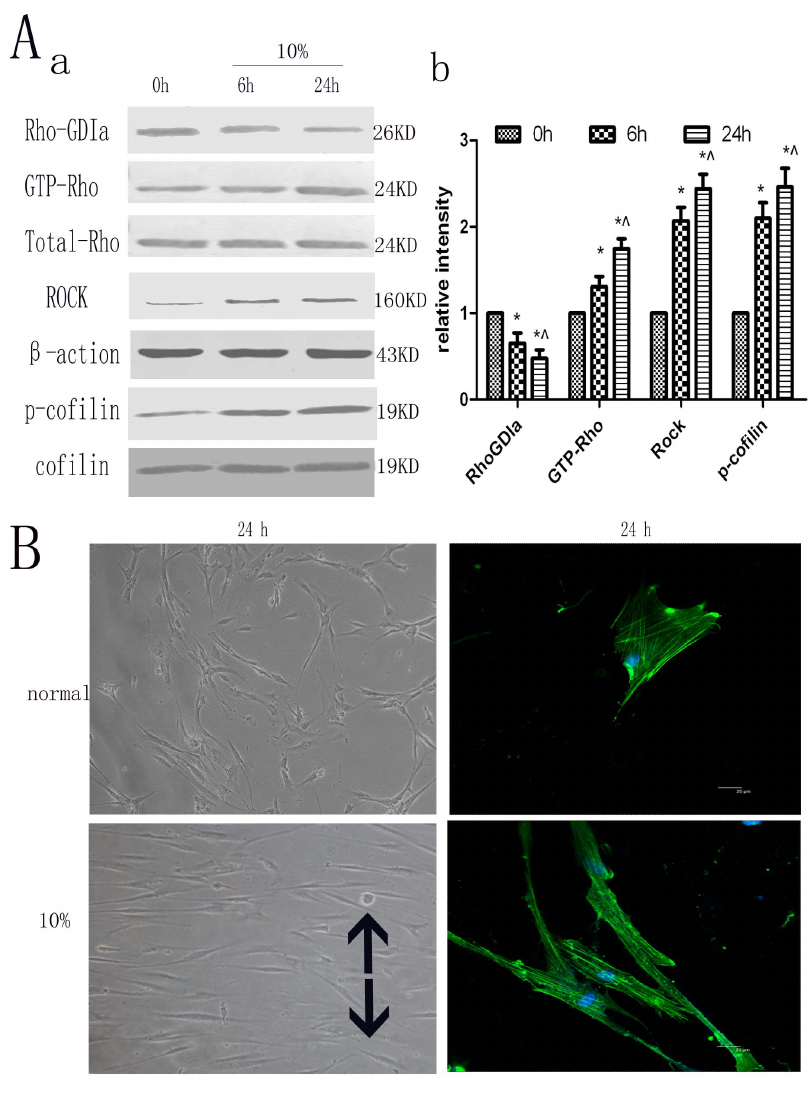
Figure 1. The effects of cyclic strain on the expression of Rho signaling pathway proteins and on cytoskeletal rearrangement of hPDLCs. (A) Effects of cyclic strain on Rho-GDIa, GTP-Rho, Rock and p-cofilin protein expression. Cells under cyclic strain of 10% physiological loading had Rho-GDIa protein expression levels that were significantly less than those in the static control, while the expression levels of GTP-Rho, Rock and phospho-cofilin were increased compared to those in the static control. Values shown are the mean 6 SD for each group from three independent experiments. * p , 0.05 vs. control group, ‘ p , 0.05 vs. cyclic strain (6h). All the band intensities are firstly normalized to the loading controls then normalized to the 0h treatment and loading control ratio (B) Effects on cell morphology and cytoskeletal rearrangement as seen with cytoskeleton staining. The unstimulated control cells contained randomly oriented cytoplasmic fibers, while the cyclic strain-treated cells were gradually arranged parallel to each other, perpendicular to the direction of the tension force, with elongated cell bodies. The black arrows show the direction of stretching (Cell morphology original magnifications 6 200, Cytoskeletal rearrangement Bar: 25 m m).